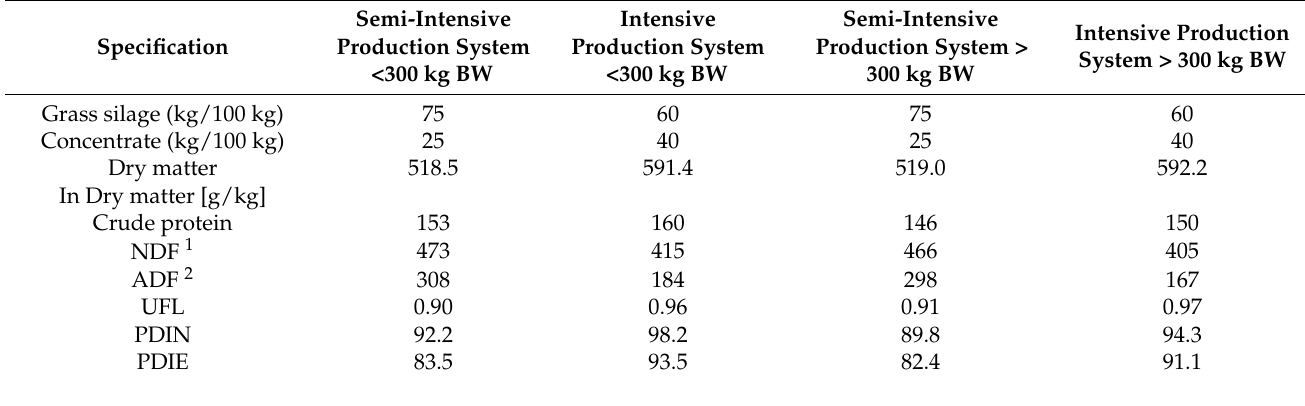
Table 2. Composition and nutritional value of the total mixed ration